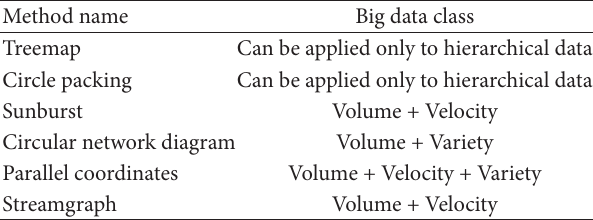
Table 2: Visualization methods